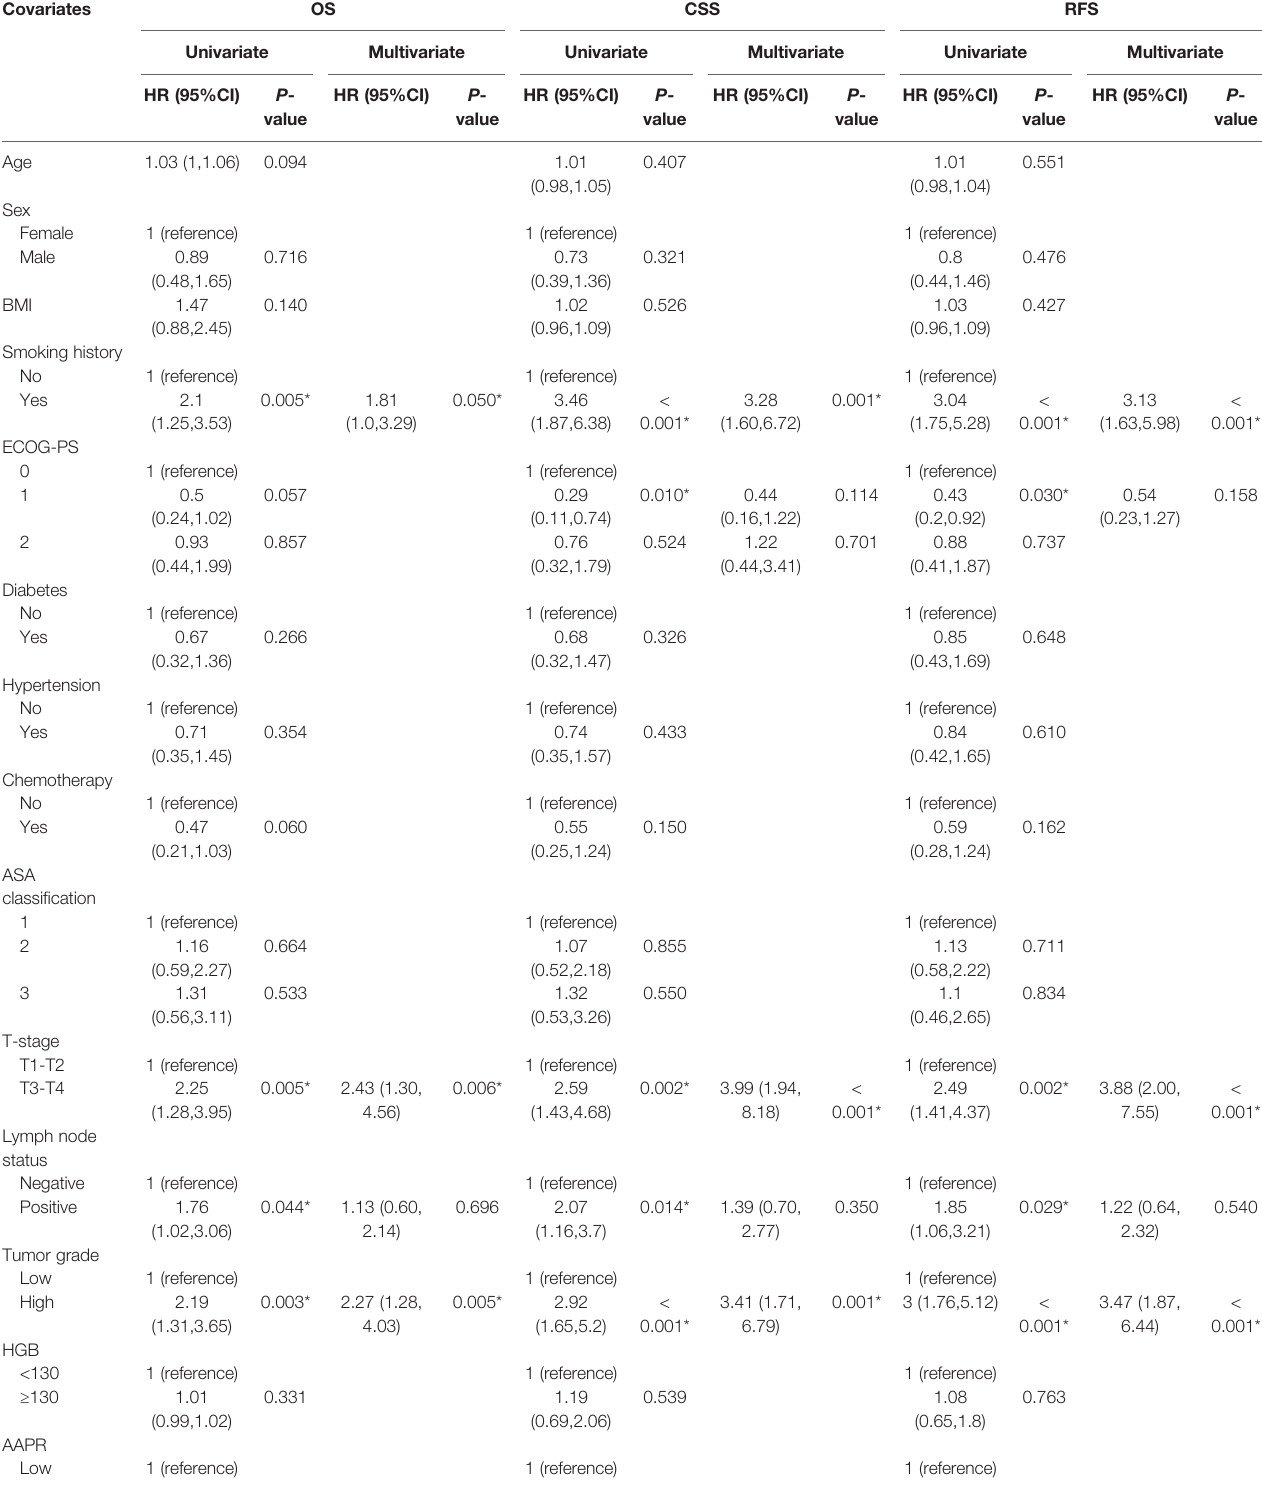
TABLE 2 | Prognostic factors for OS, CSS and RFS of BC patients treated with RC in univariate and multivariate Cox regression analyses. Covariates OS CSS RFS Univariate Multivariate Univariate Multivariate Univariate